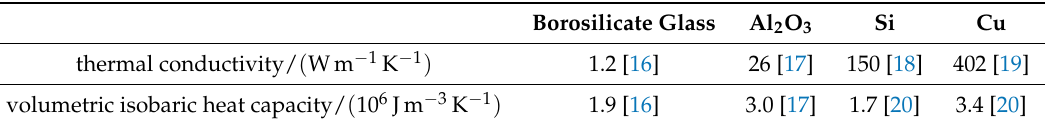
Table 1. Thermal conductivities and volumetric heat capacities at room temperature of the different substrate materials used in the present